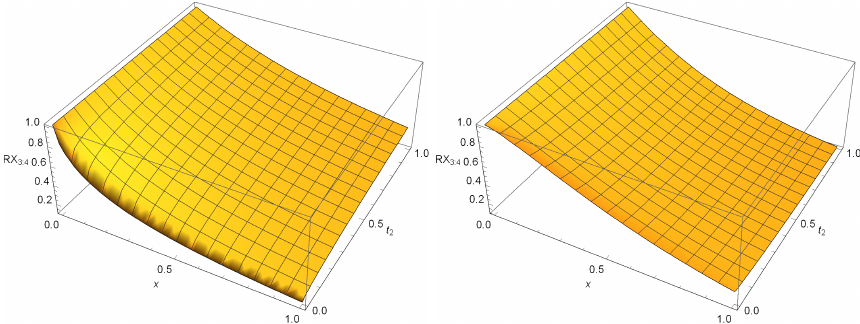
Figure 2. The graphs of the reliability function of RX 3:4 ( t 1 , t 2 ) , for the Weibull ( α = 0.6, λ = 1.1 ) ( left ) and ( α = 1.3, λ = 0.8 ) ( right ).